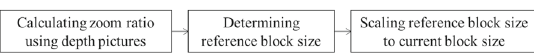
Fig. 2 Approximation of relationship between distance and width of object Fig. 3 Flowchart of proposed method for color